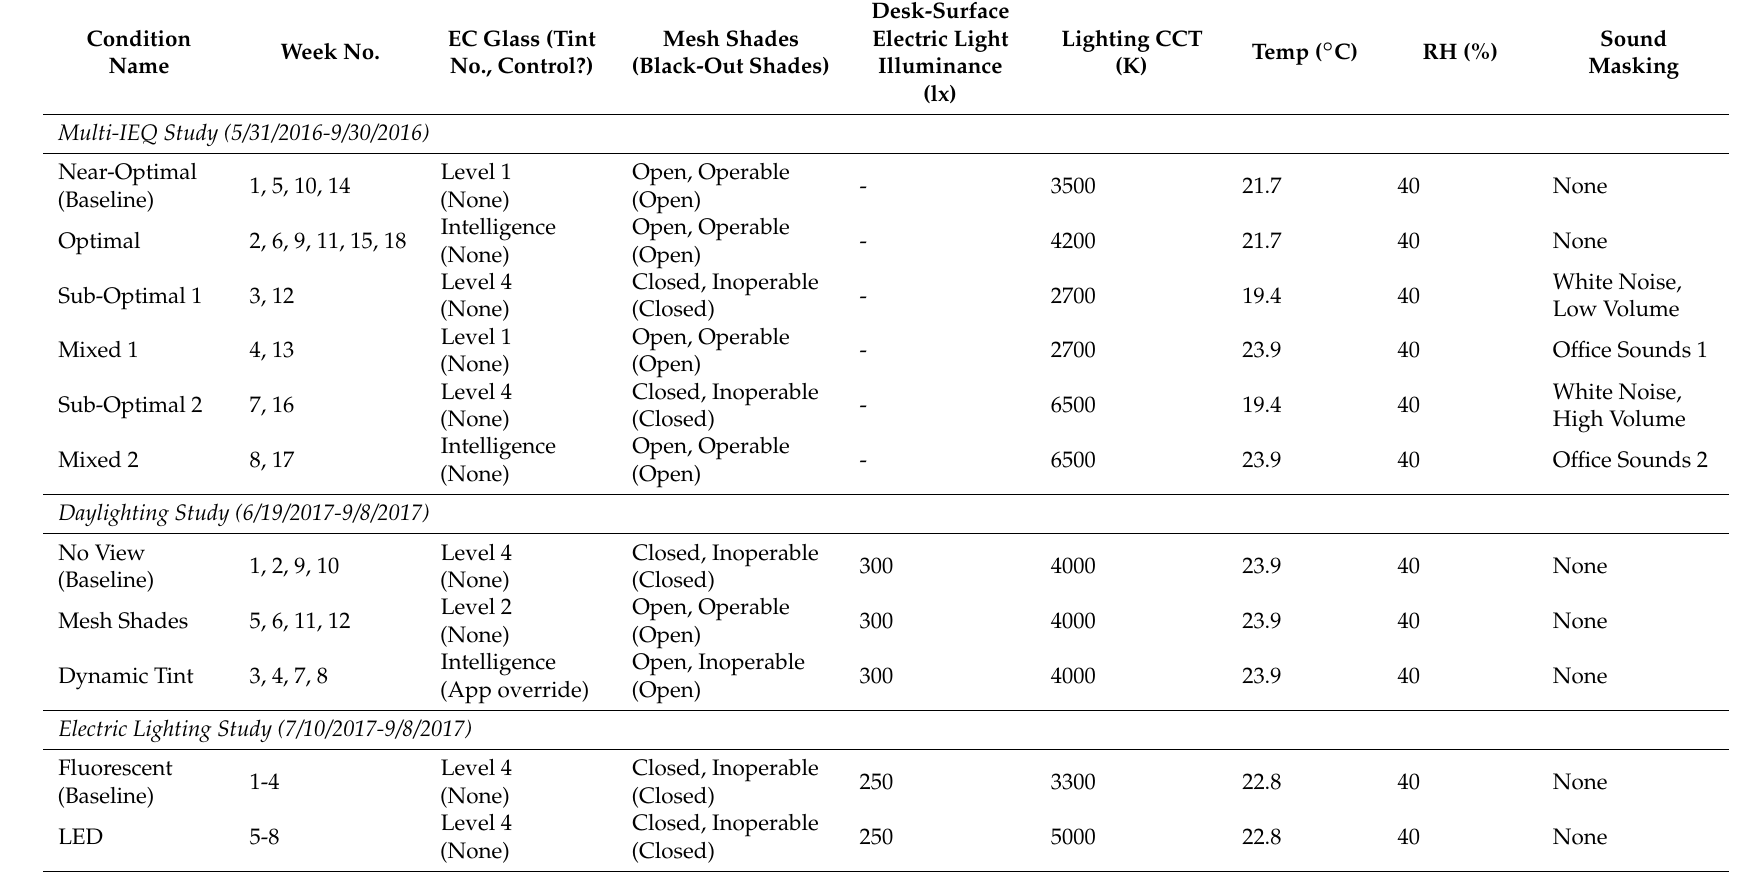
Table 1. Experimental design summary of three office-based living lab